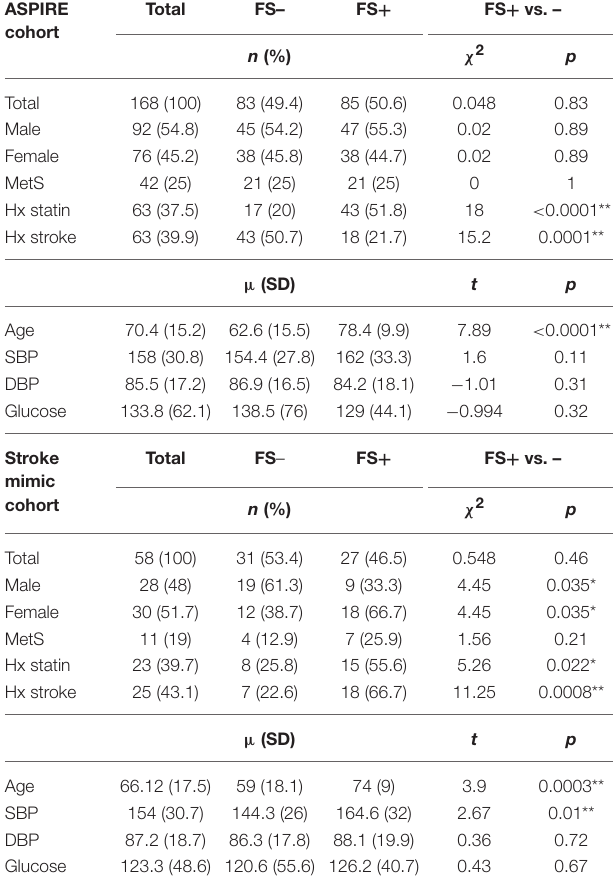
demonstrated a cross-validated R 2 of 12.54%,